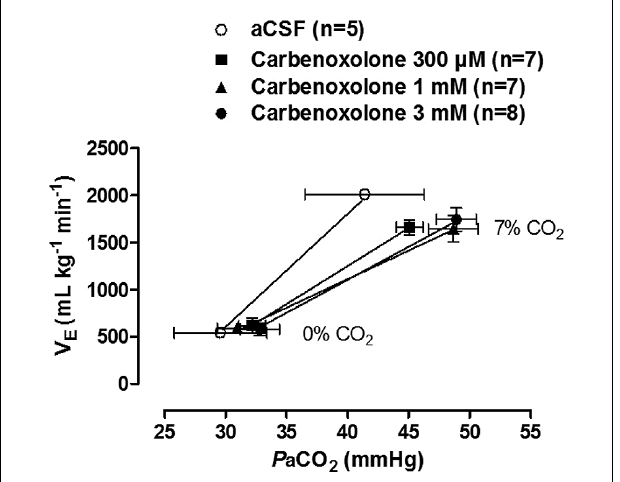
FIGURE 1 | Effect of bilateral intra-LC microinjections of vehicle (aCSF/100 nL) or carbenoxolone (300 μ M, 1 mM, or 3 mM/100 nL) on CO 2 sensitivity (relationship between and PaCO 2 ). Values are expressed as mean ± SEM.The 1 and 3 mM carbenoxolone sensitivity curves presented lower slopes than the vehicle curve ( P < 0.01).With permission from Elsevier (Patrone etal., 2014).